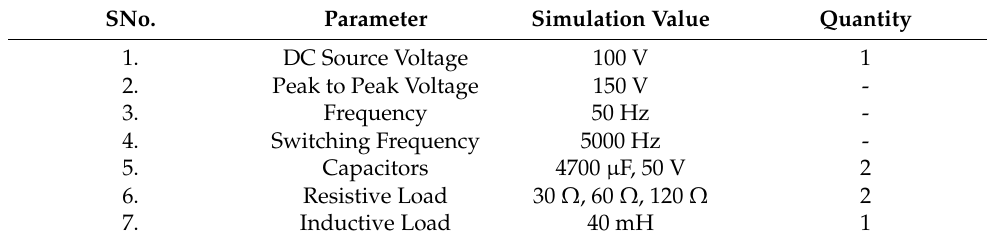
Figure 7. ( a ) Load voltage and load current waveforms at h = 0.03. ( b ) Harmonic spectrum of load voltage. ( c ) Harmonic spectrum of current waveforms at h = 0.03. Table 2. Simulation